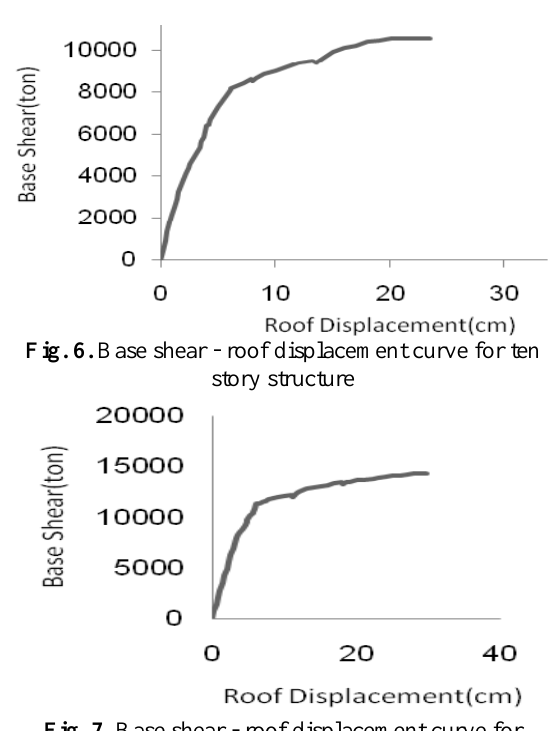
Fig. 7. Base shear - roof displacement curve for fifteen story